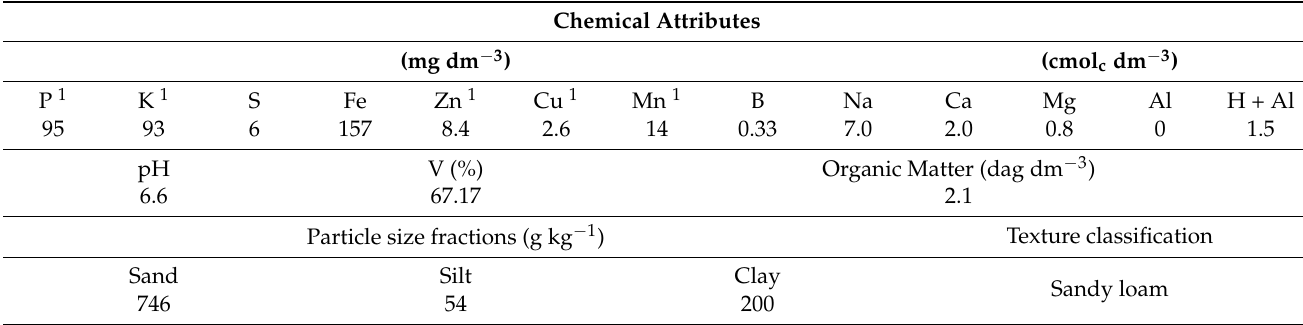
Table 8. Chemical attributes and granulometric fractions of the soil in the experimental area. S ã o Mateus, state of Esp í rito